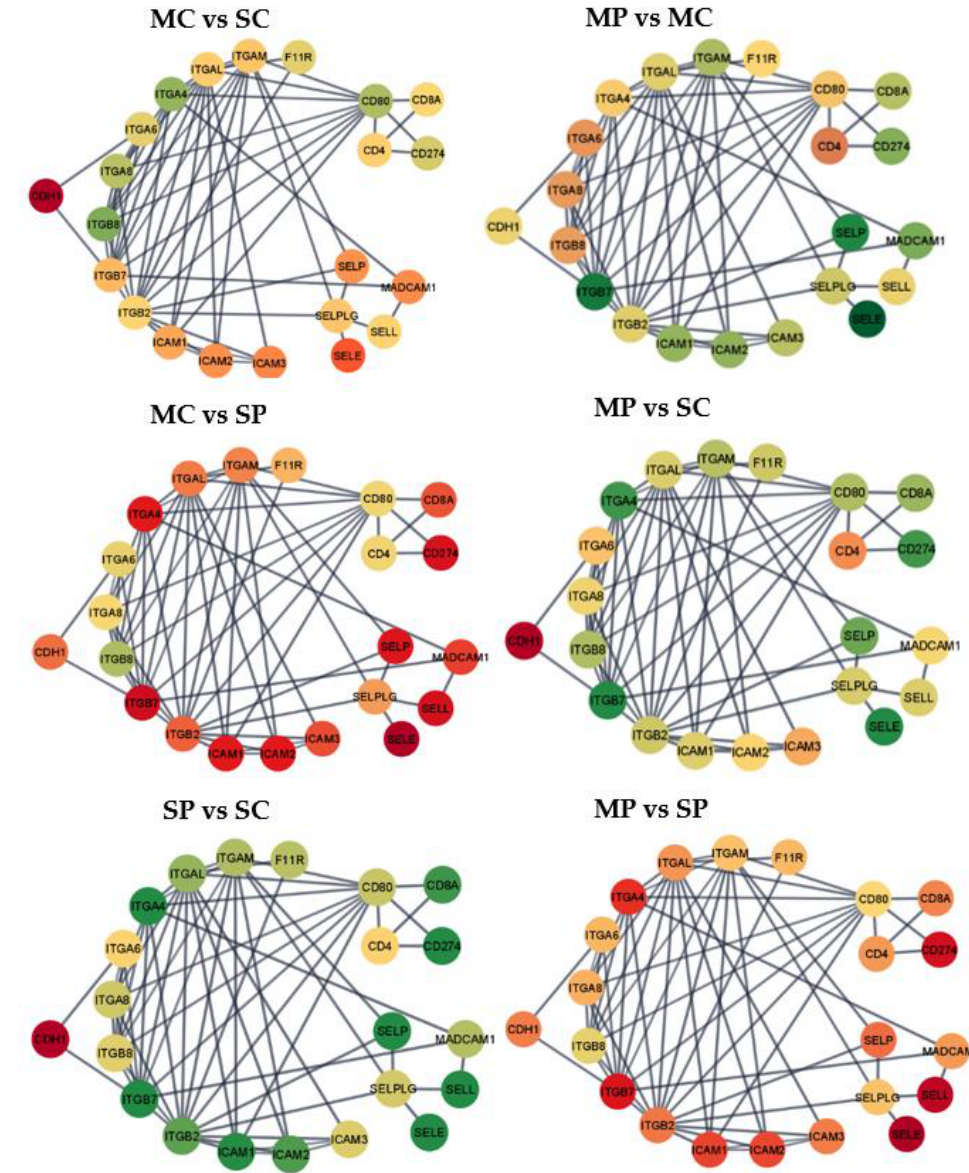
Figure 1. Gene networks for the cell adhesion molecules pathway. Nodes = genes; edges = STRING database connections; node color = differential expression between groups characterized by opioid (M = morphine or S = saline) followed by MIA exposure (C = control or P = viral MIA) from red (under-expressed in the first vs. second group, to yellow, and green (over-expressed in the first versus second group. Networks: MC vs. SC = morphine-treated Control vs. saline-treated Control; MP vs. MC = morphine-treated MIA vs. morphine-treated Control; MC vs. SP = morphine-treated Control vs. saline-treated MIA; MP vs. SC = morphine-treated MIA vs. saline-treated Control; SP vs. SC = saline-treated MIA vs. saline-treated Control; and MP vs. SP = morphine-treated MIA vs. saline-treated MIA.